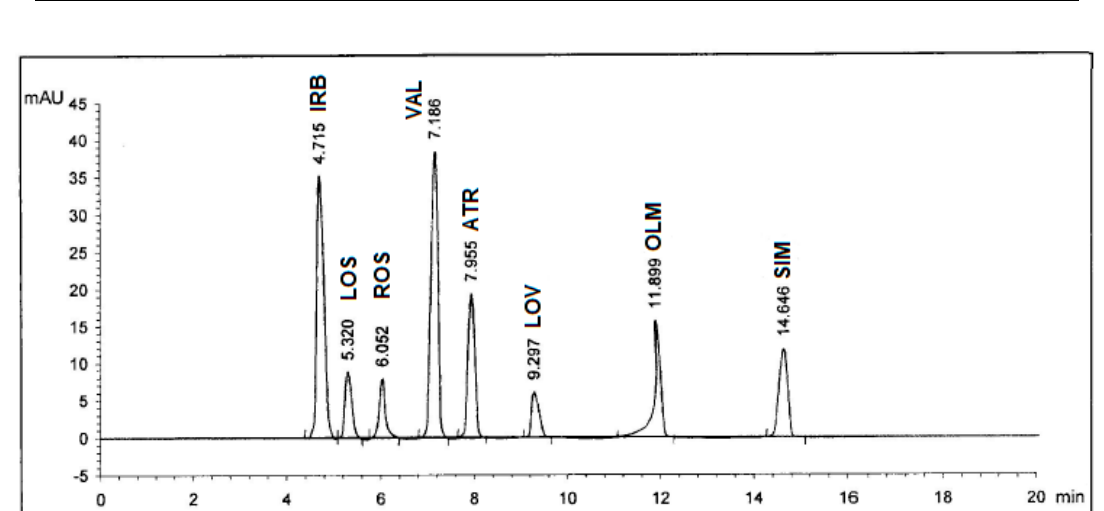
Figure 3. HPLC Chromatogram of authentic mixture containing Irbesartan ® (IRB), Losazide ® (LOS), Estromap ® (ROS), Tareg ® (VAL), Ator ® (ATR), Lovastmed ® (LOV), Erastapex ® (OLM), and Alkor ® (SIM) tablets dosage forms at 280 nm. Other optimum chromatographic conditions are stated in Table 1.